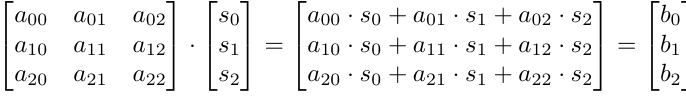
Figure 4: Matrix-vector multiplication A · s = b in Saber as shown in Alg. 1 and Alg. 2 for l = 3. The addition of constant h is omitted for ease of reading.